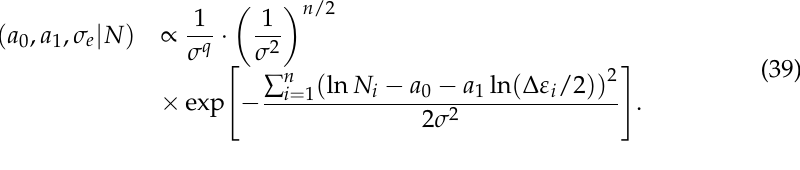
Table 2. Low-cycle fatigue testing data. Source: